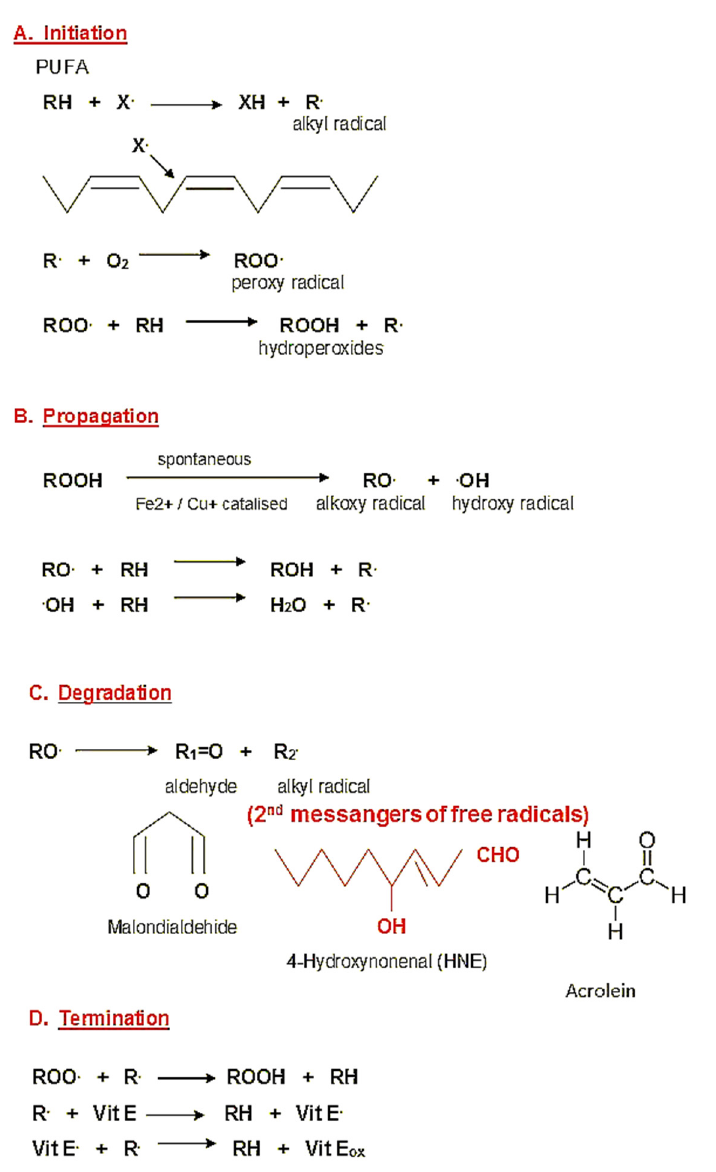
Figure 1. Generation of HNE as a product of lipid peroxidation. ( A ) Due to the attack of oxygen free radical X. (mostly hydroxyl radical) on the omega-6-poylunsaturade acids (PUFA), the chain-reaction of lipid peroxidation is initiated. ( B ) Lipid hydroperoxides can be spontaneously or under the influence of transition metals further metabolized generating radicals themselves. ( C ) The end products of oxidative degradation of PUFA are reactive aldehydes, among which HNE exhibits the most prominent biochemical and biomedical e ff ects, acting as a second messenger of free radicals. ( D ) In the case of the presence of lipid-soluble antioxidants, the initial stage of lipid peroxidation can be terminated.